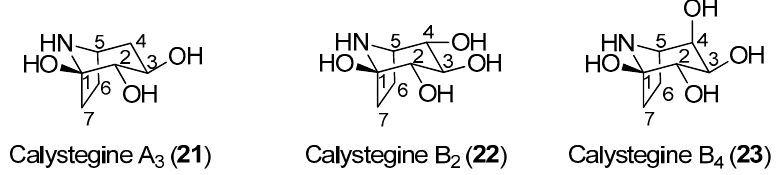
Figure 4. Structures of calystegines A 3 , B 2 , and B 4 .